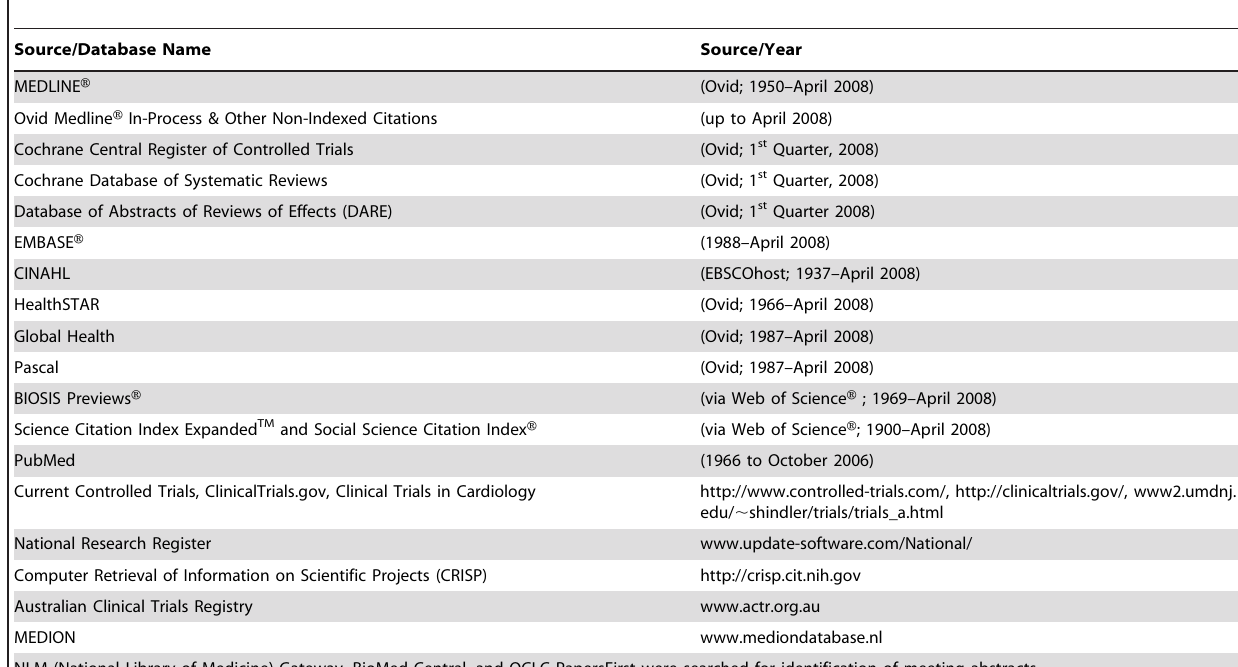
Table 1. Databases and Trials Registers Included in